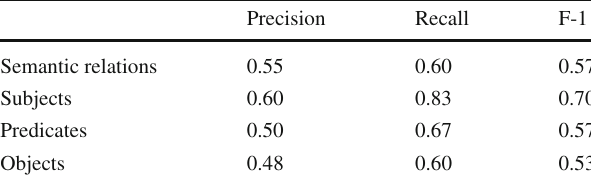
Table 9 Evaluation of RDF triple elemenets